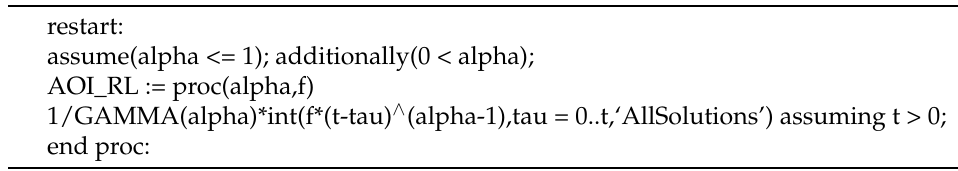
Table 1. Maple 18 code of